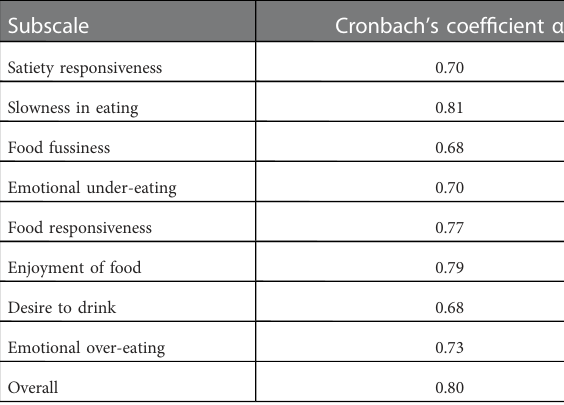
TABLE 2 Reliability of CEBQ ( n =1935).